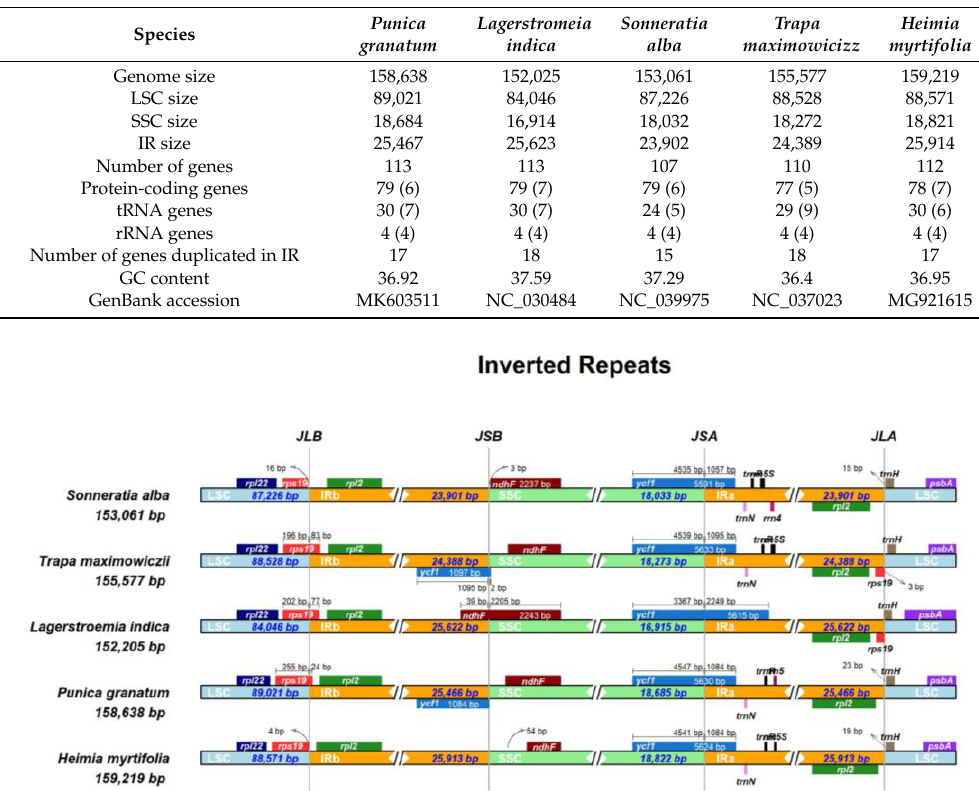
Figure 4. Comparison of the borders of the LSC, SSC, and IRs regions among five Lythraceae cp genomes.